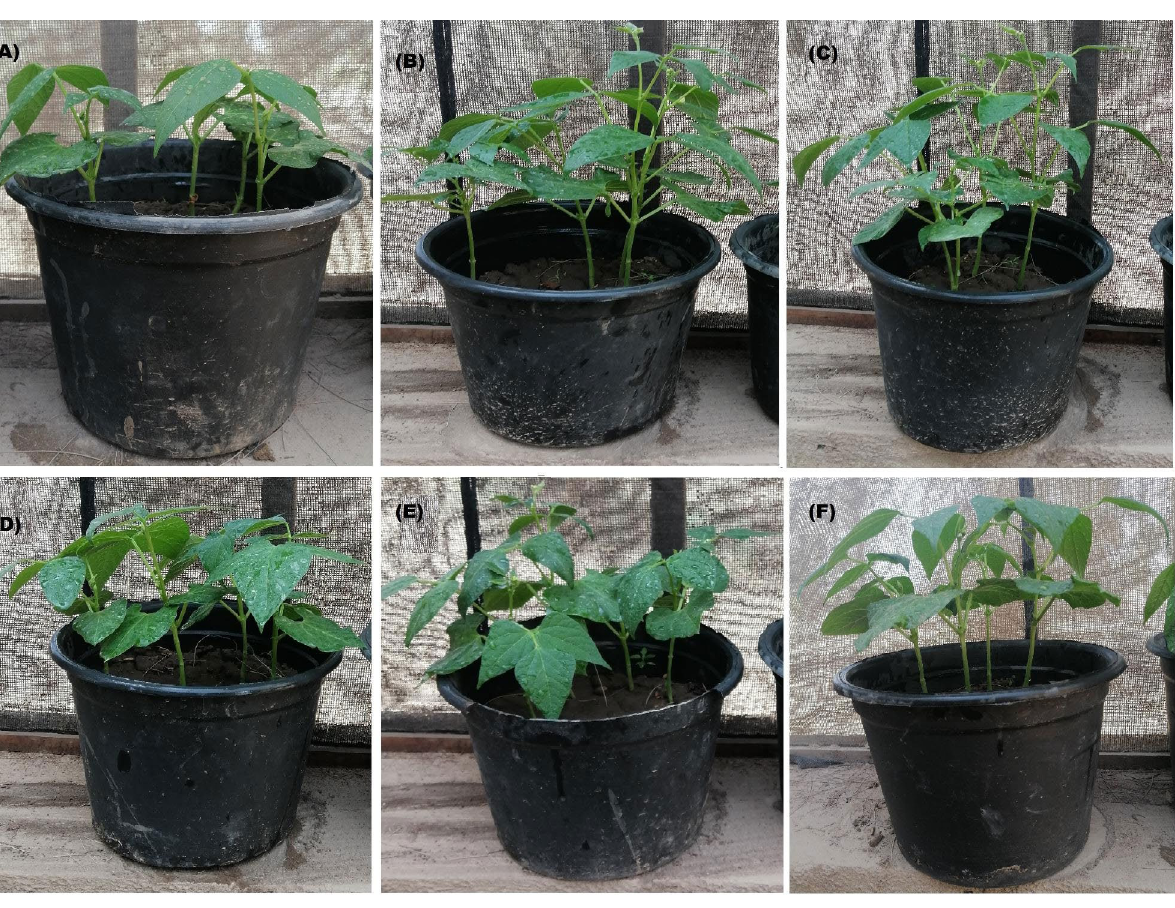
Fig. 4 Photographs of the effect of different NPs on promoting growth of Phaseolus vulgaris . Treatment with Co 3 O 4 NPs (A) , Treatment with CuONPs (B) , Treatment with Fe 3 O 4 NPs (C) , Treatment with NiONPs (D) , and Treatment with ZnONPs